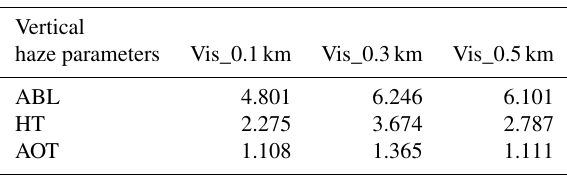
Table 1. Statistical gradient of Up-Vis with different vertical haze parameters at different altitudes for Fig.